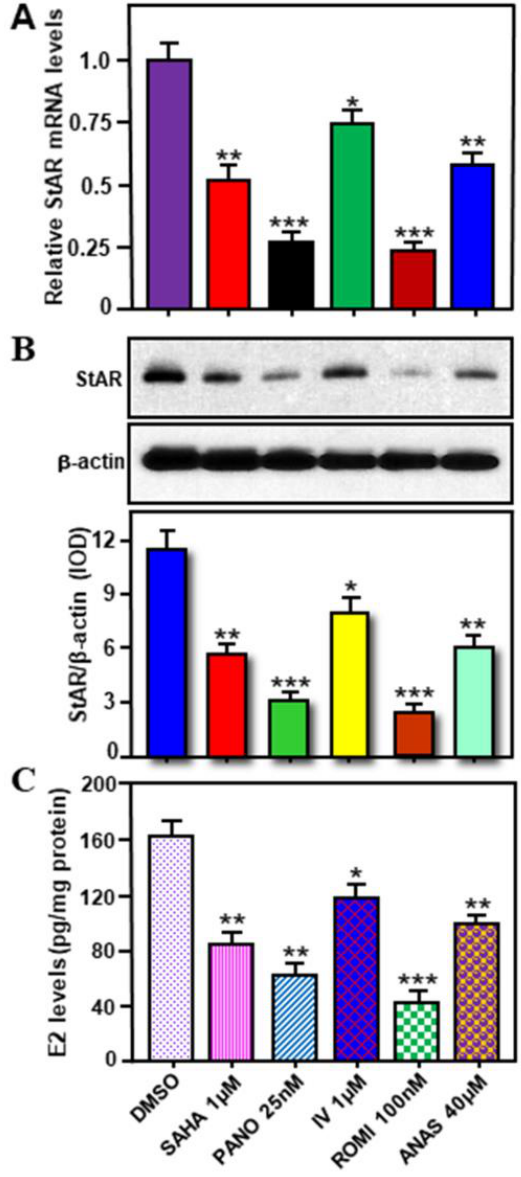
Figure 6. Assessment of StAR expression and E2 accumulation in primary cultures of breast tumor epithelial cells from MMTV-PyMT mice, and their alterations in response to HDACIs. These cells were treated without (DMSO) or with SAHA (1 µ M), PANO (10 nM), inhibitor IV (IV; 1 µ M), Romidepsin (ROMI; 1 µ M), and Anastrozole (ANAS, 40 µ M), for 24 h. After treatments, cells were subjected to total RNA extraction for determining StAR mRNA expression by RT-qPCR ( A ). Cells were also processed for whole cell extract preparation, and representative immunoblots show expression of StAR protein using 60–70 µ g of total protein ( B ). β -actin expression was assessed as a loading control. IOD values for StAR and aromatase, in each band, were quantified and normalized with the corresponding β -actin bands, and presented ( B , bottom panel). E2 levels in media were determined by ELISA and presented as pg/mg protein ( C ). Data represent the mean ± SE of three independent experiments. *, p < 0.05; **, p < 0.01; ***, p < 0.001 vs. DMSO.